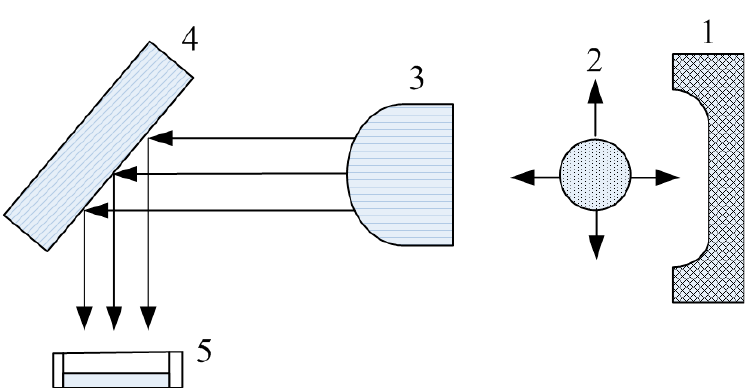
Figure 1. The scheme of the irradiation installation; 1—reflector, 2—mercury lamp, 3—focusing lens, 4—rotary mirror, and 5—Petri dish with sample.